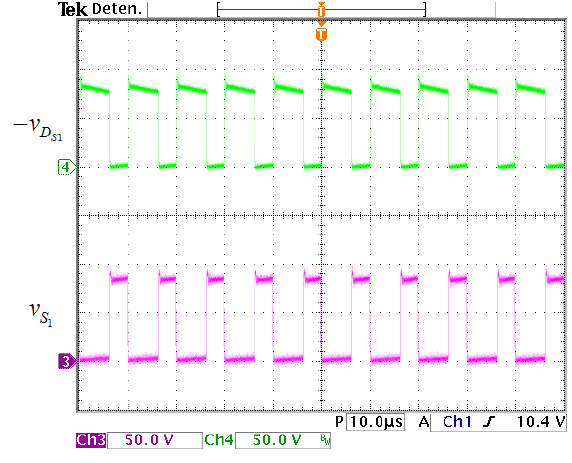
Figure 21. Voltage waveforms in the input of converter. (From top to bottom) Voltage waveforms in